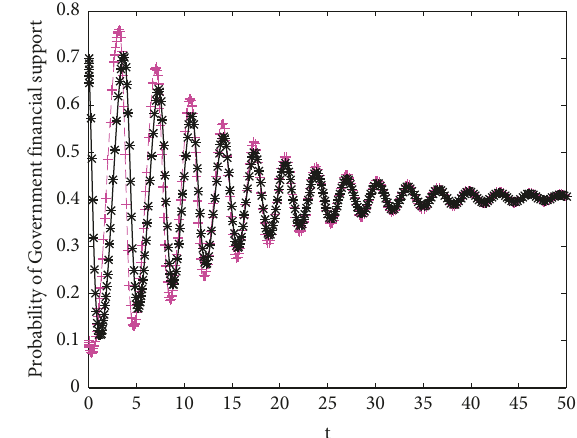
Figure 7: The evolution path of government financial support under the dynamic incentives mechanism and penalties mechanism.